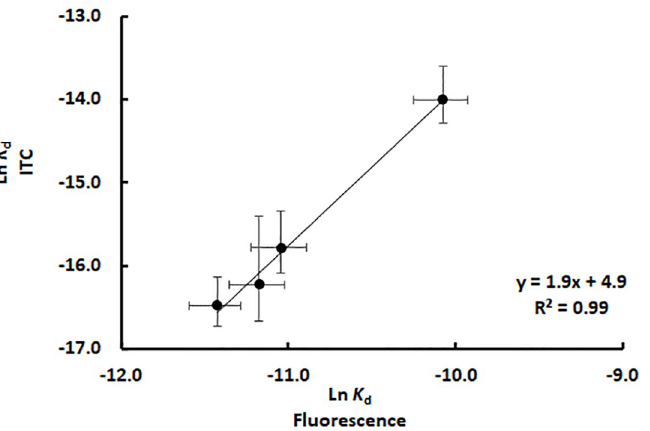
Fig 7. Correlation between K d of the HisF-HisH heterodimer determined using the intrinsic fluorescence and ITC methods.